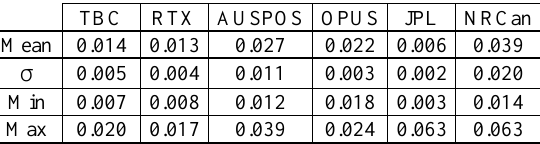
Table 2. Statistics for the uncertainty of the